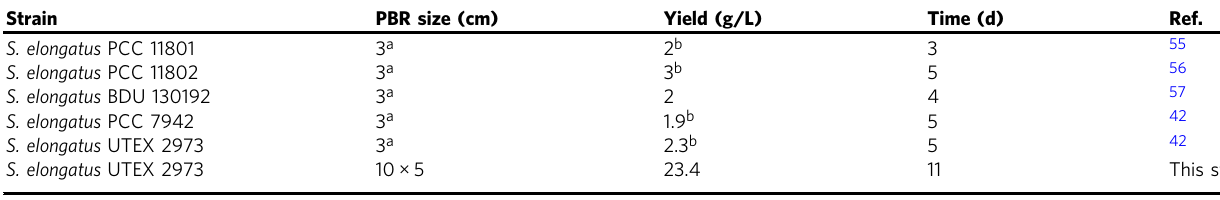
Table 2 Select publications on cyanobacterial biomass production with PBRs.